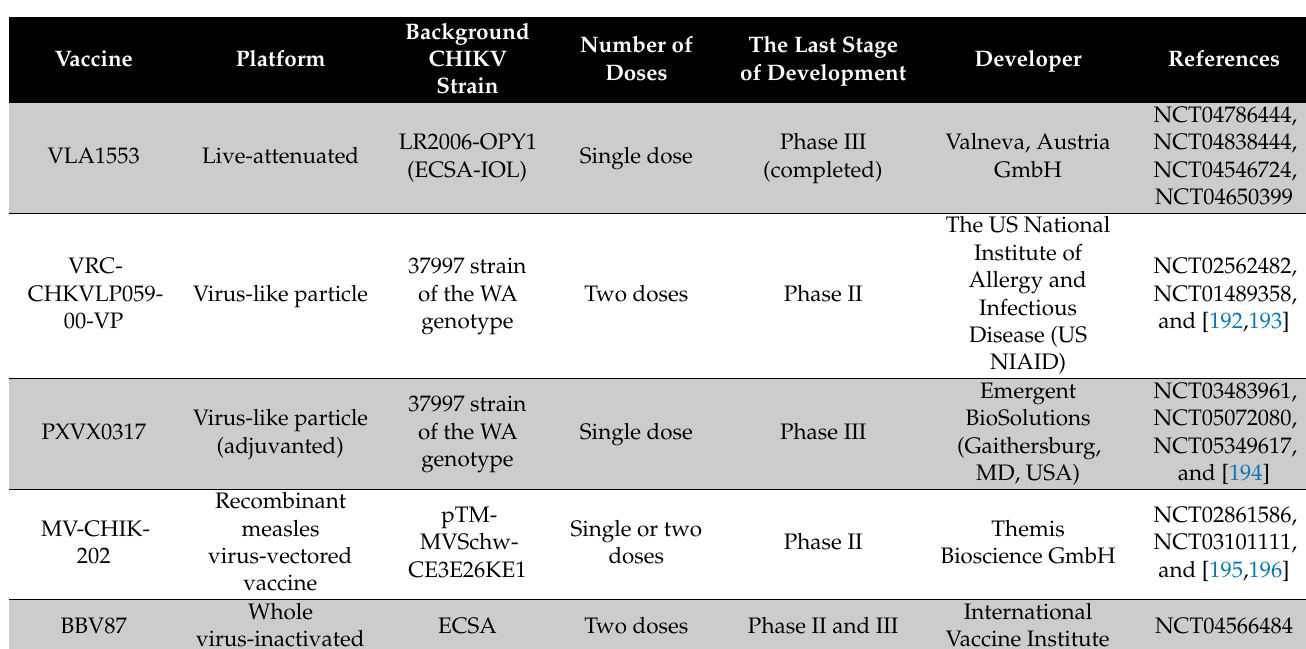
Table 2. The summary of the recent CHIKV vaccine candidates in phase II/III clinical